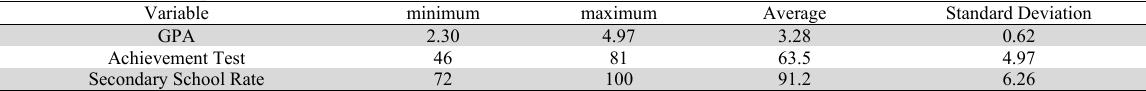
Characteristics of independent variables